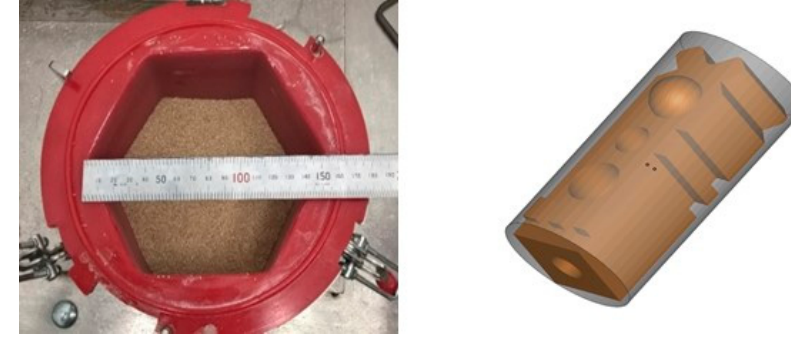
Figure 5. High-energy centrifuge and design space for part (grey shaded area).